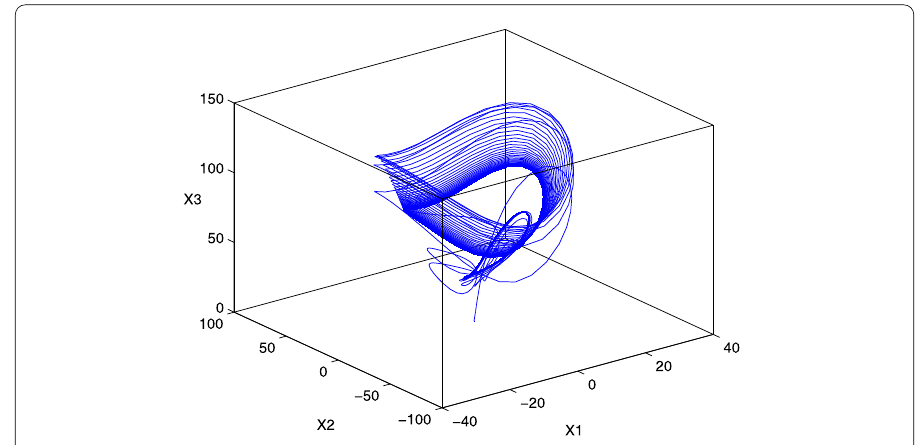
Figure 2 The chaotic state of the first cluster